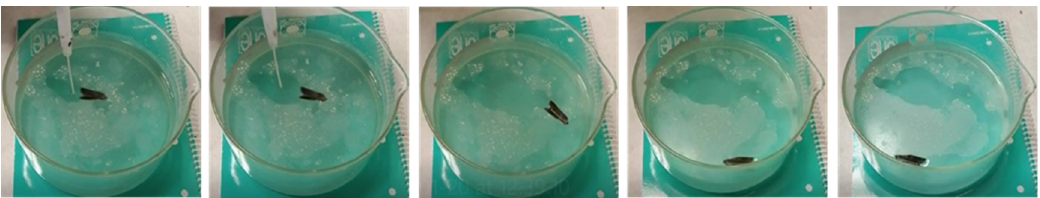
Figure 9. The locomotion and formation of the polymeric layer work even in the case of a uniform monolayer film created using commercial talc powder and move the powder away, cleaning the corresponding area.